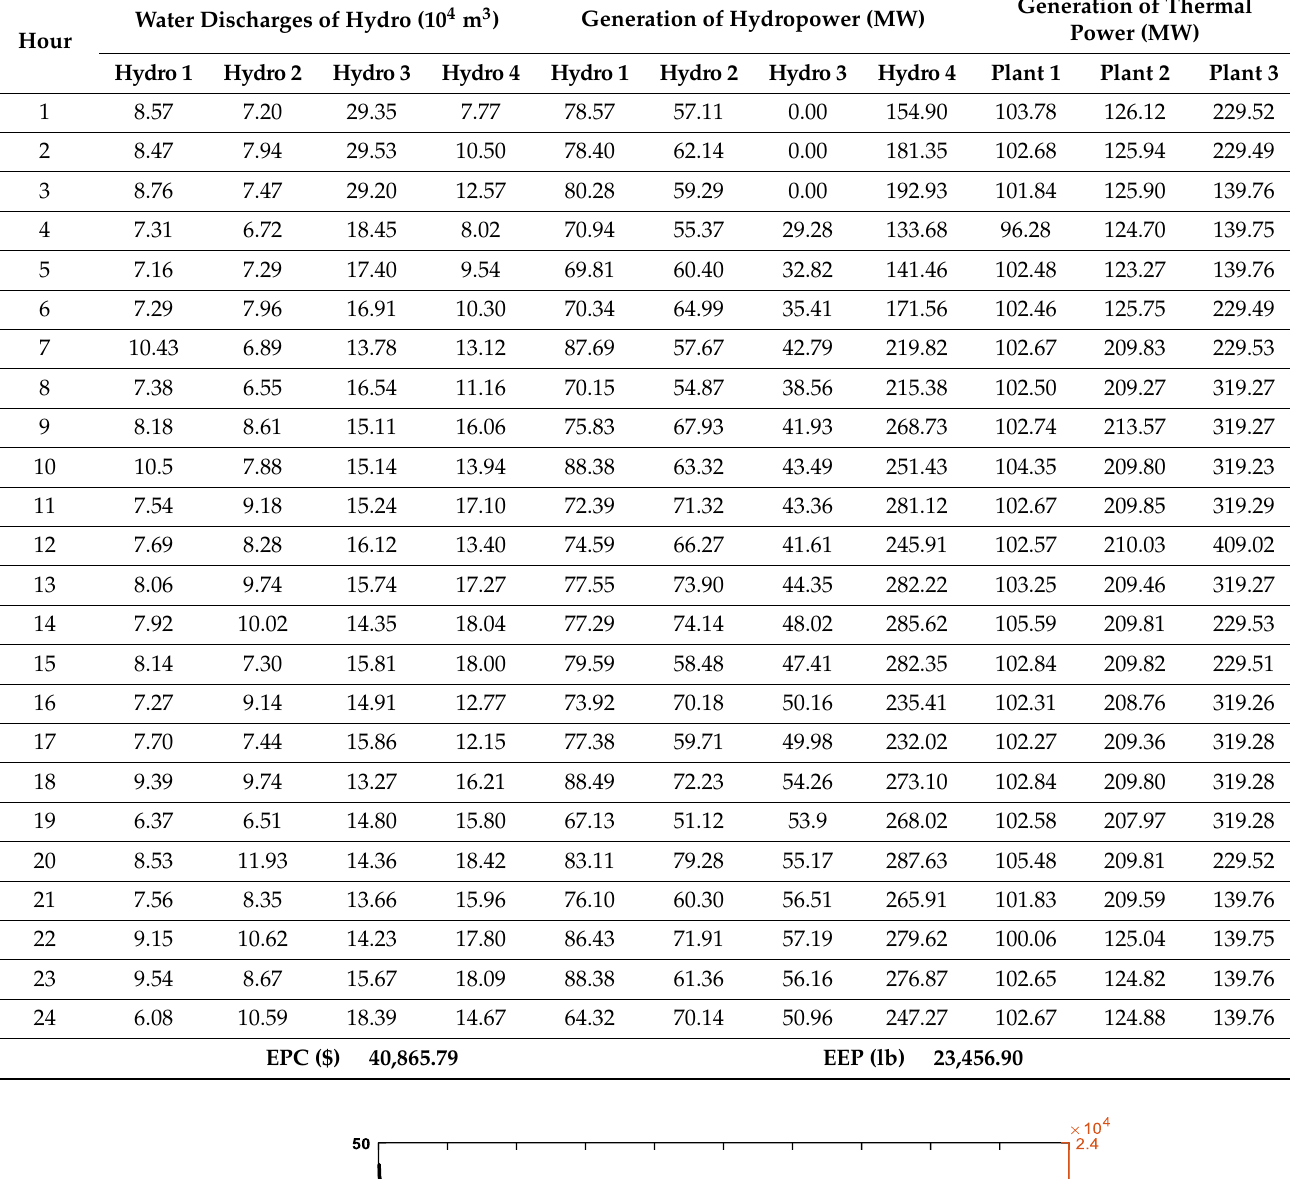
Table 2. EPC minimization schedule results with DOGSA of Test System-I.